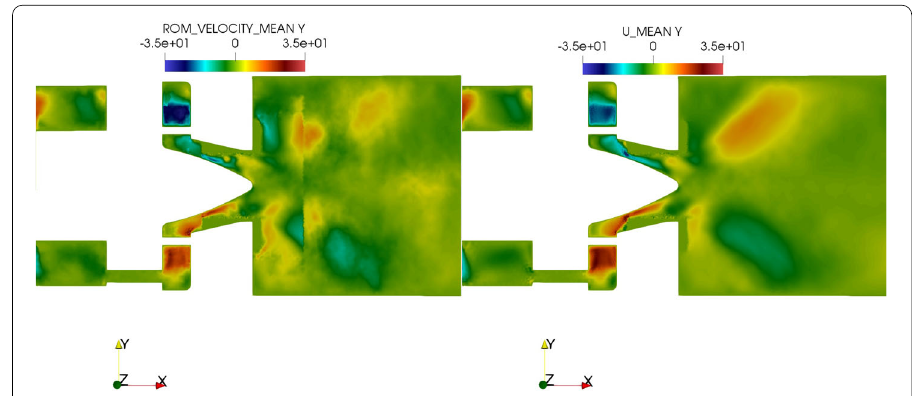
Fig. 48 Smaller RFD. On the left, the second component of the mean flow field by the UGPOD applied to configuration 1. On the right, the second component of the high fidelity mean flow field with configuration 1